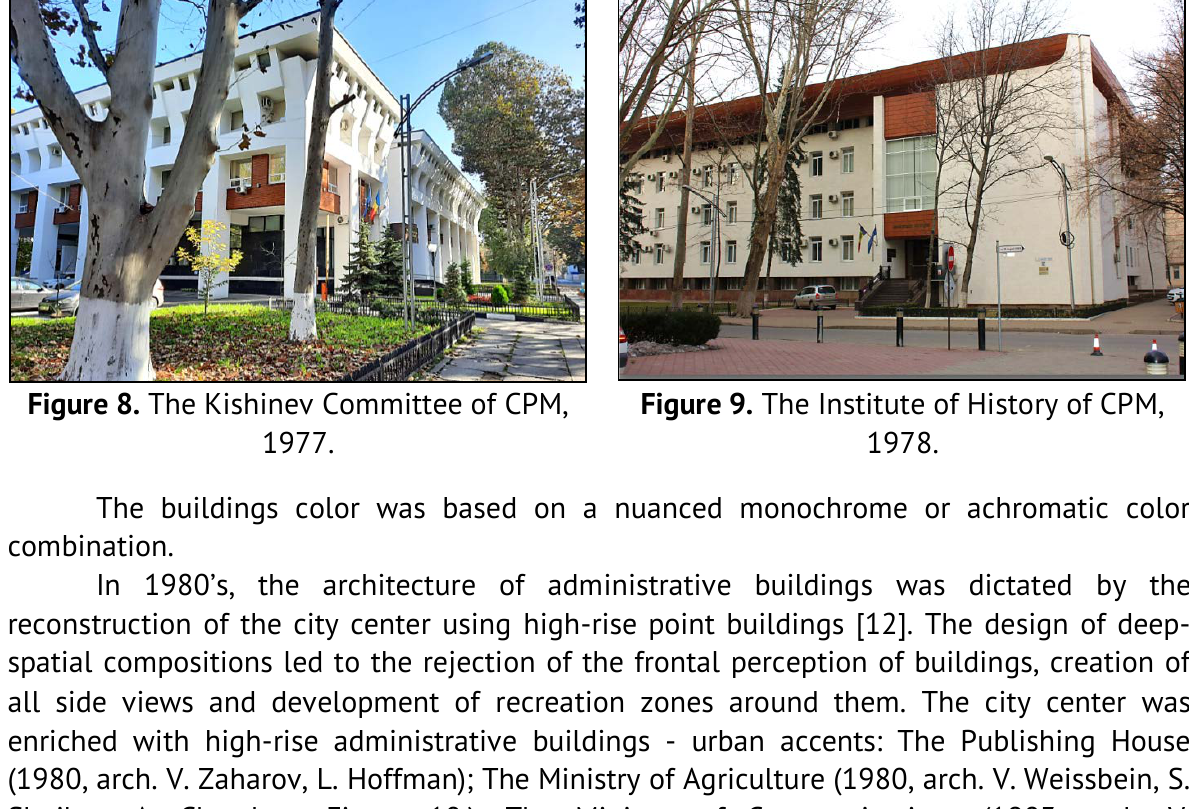
Figure 8. The Kishinev Committee of CPM, 1977.